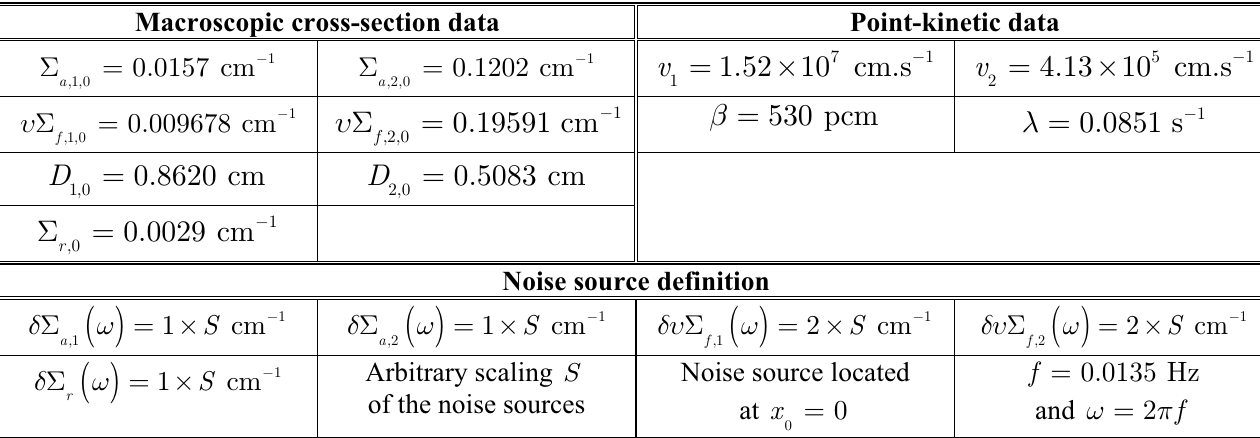
Fig. 1 Representation of the homogeneous test case. Table 1. Definition of the homogeneous test